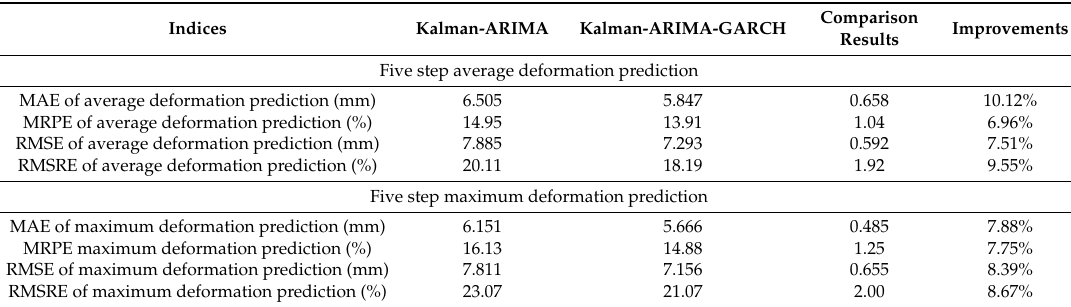
Table 3. Analysis of the predictions given in Figure